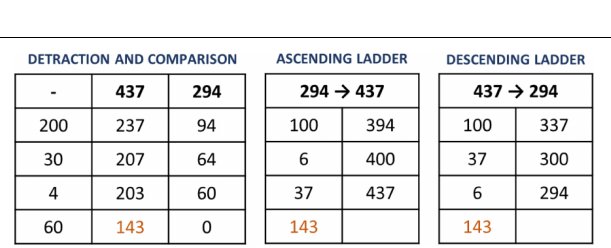
FIGURE 8 | Addition phases in Open Algorithm Based on Numbers method.